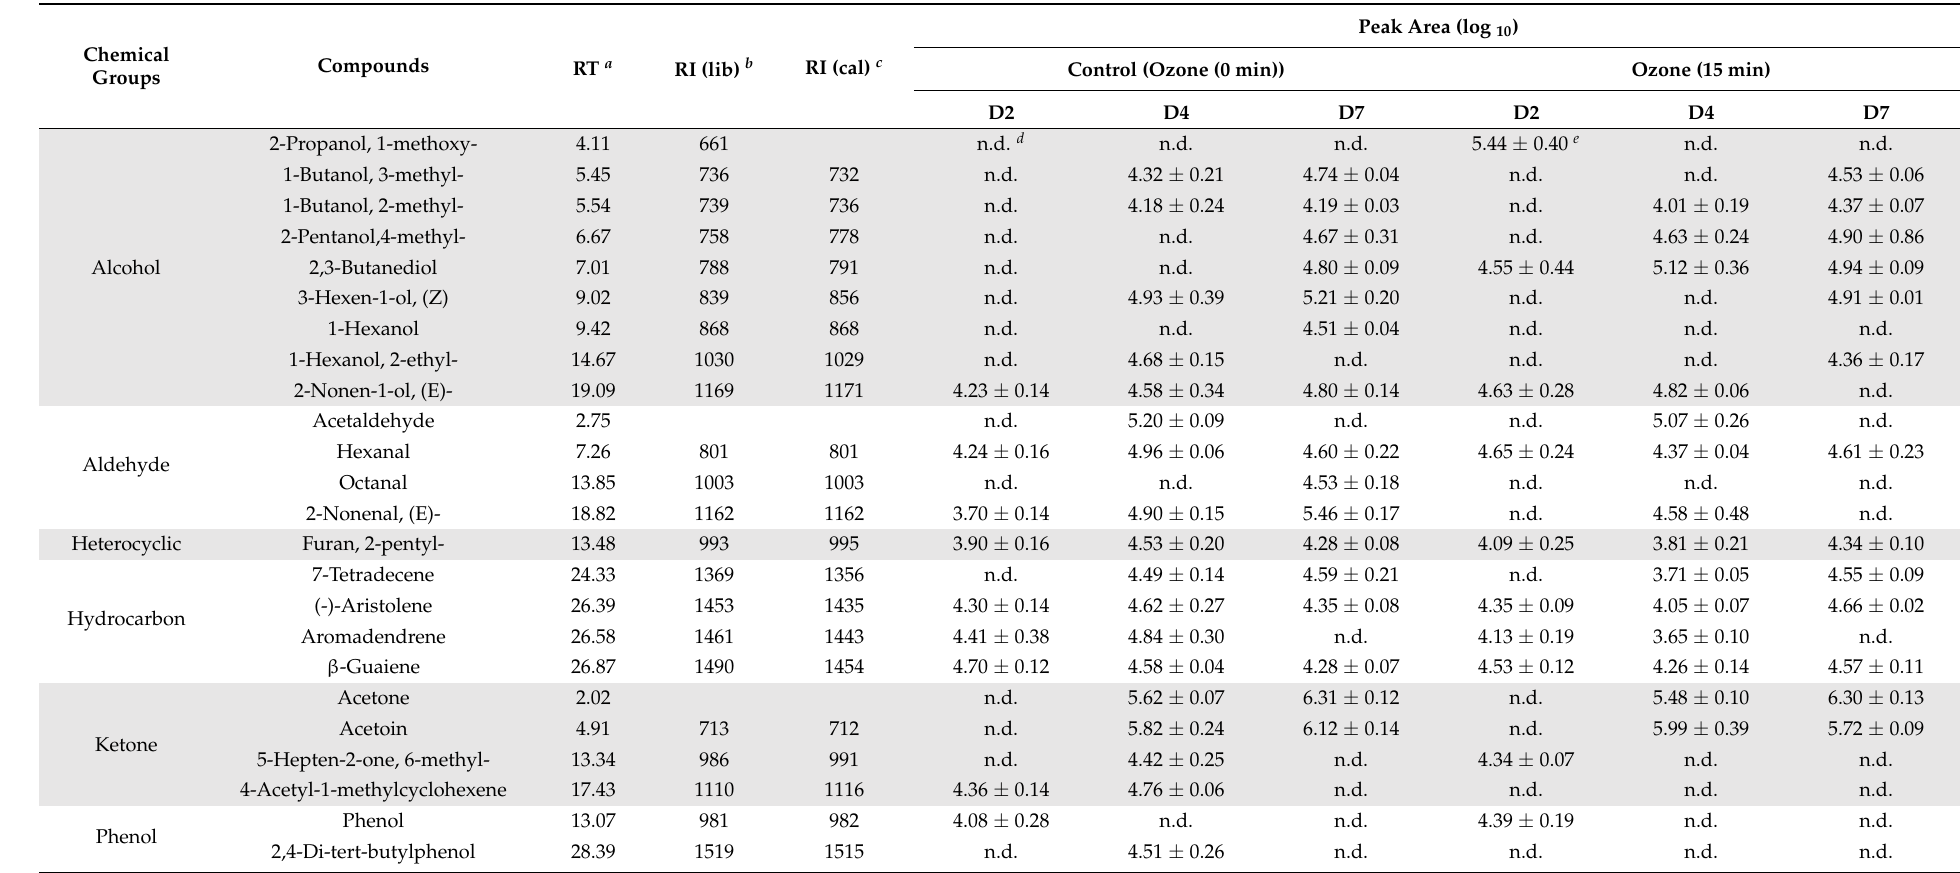
Table 1. Analysis of volatile compounds of germinating barley seeds (Scope CL) under different ozone treatment times by